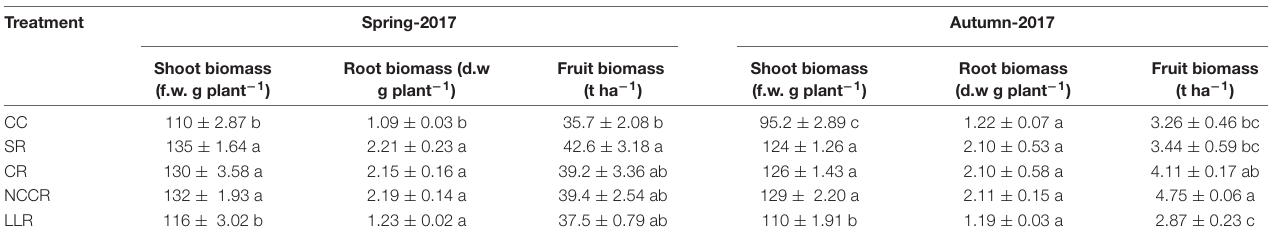
TABLE 1 | Plant growth observations of cucumber under different cropping treatments (Means ± SE, n = 3).